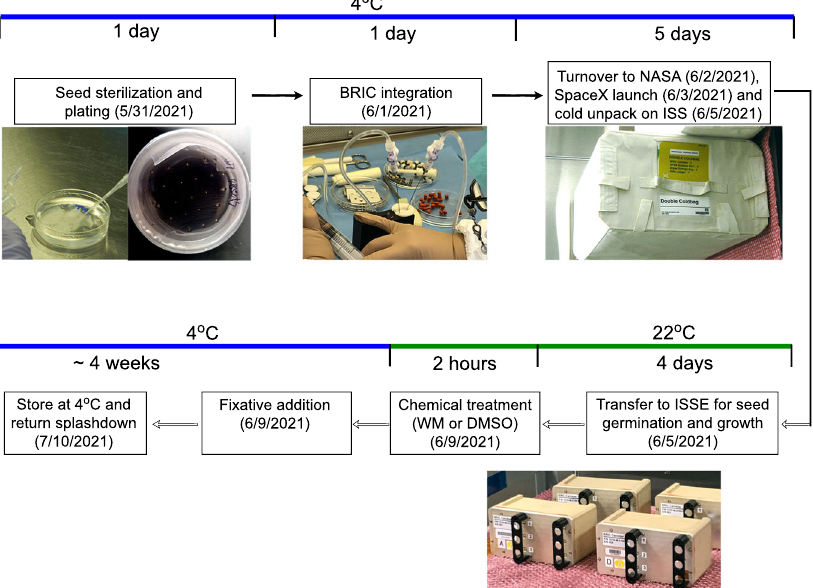
Fig. 1 Overview of the BRIC-24 experimental work fl ow. Sterilized Arabidopsis seeds (WT and zig-1 with GFP-TIP2;1) were plated onto AGM media and stored at 4 °C before BRIC-PDFU integration. Each petri dish contained 30 seeds. Treatment solution (33 μ m WM or DMSO buffer) and fi xative were injected into the dual chamber of the PDFU. Plates were placed into each PDFUs and PDFUs were integrated into BRICs. Four BRICs were then stored in a cold bag for the fl ight. After 4 days of growth on the ISS, WM solution or DMSO control were applied to the seedlings. The treatment lasted for 2 hours. The second actuation was conducted by applying fi xative solution to the seedlings. BRICs were then kept at 4 °C and returned to NASA after splash down. Confocal imaging and data analysis were conducted at